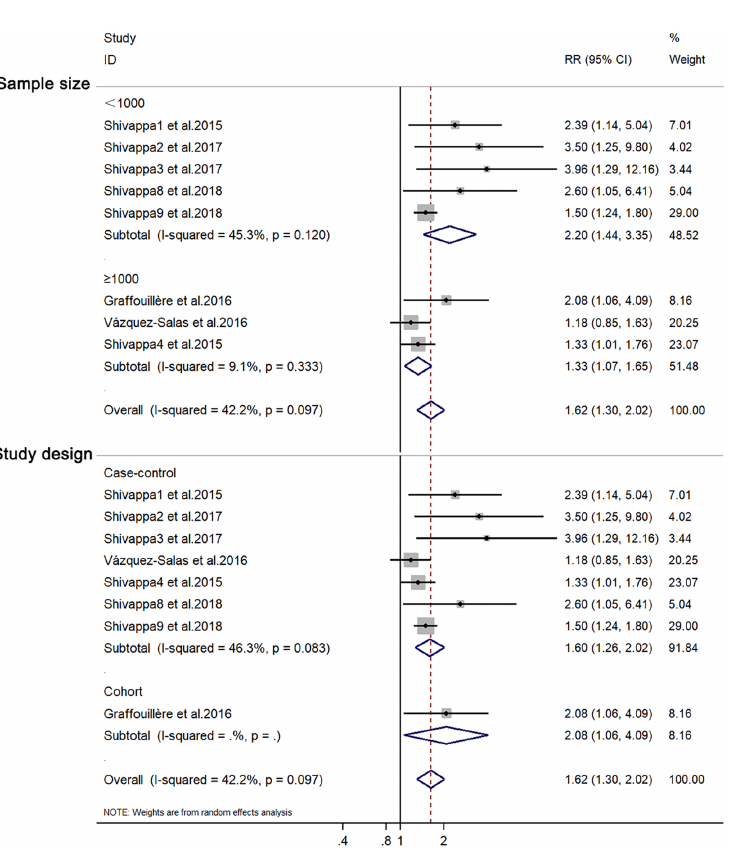
Fig 3. Forest plots showing RR with 95% CI of prostate cancer comparing the highest to the lowest dietary inflammatory index score. https://doi.org/10.1371/journal.pone.0204845.g003 PLOS ONE | https://doi.org/10.1371/journal.pone.0204845 October 1,